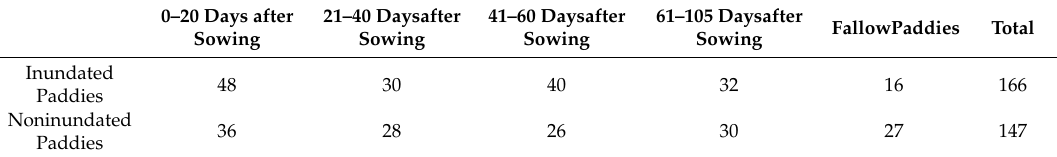
Table A2. Number of regions of interests (i.e., farmers’ rice paddies with training data).